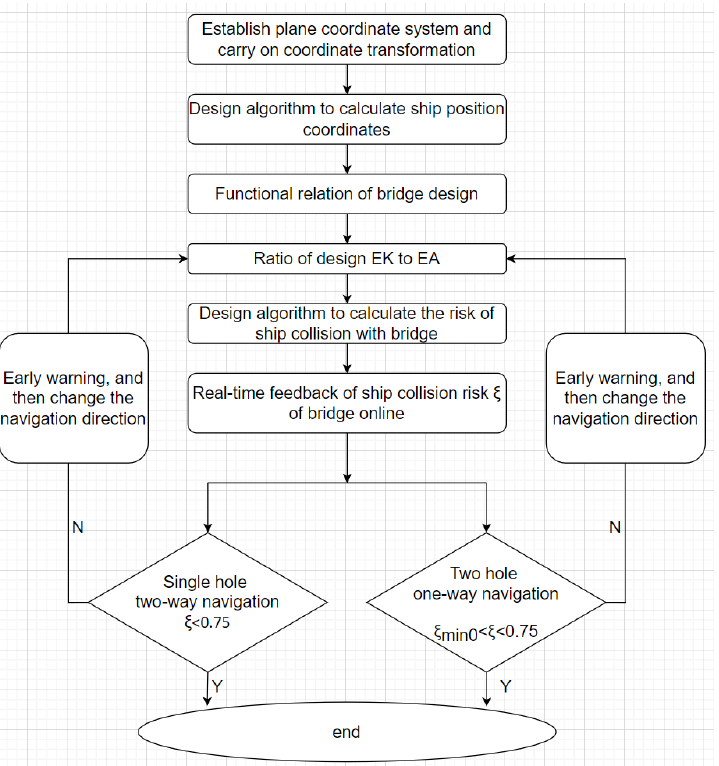
Figure 1. Flow chart of ship–bridge collision risk algorithm and early warning system.